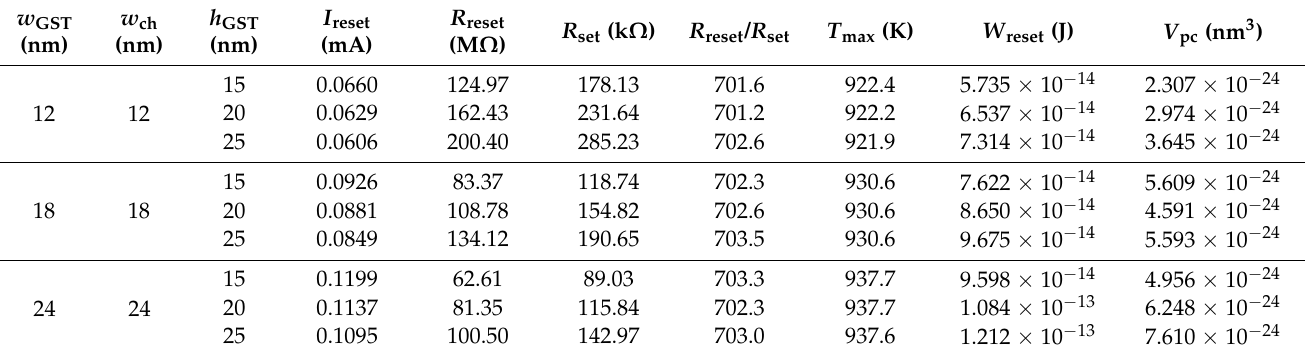
Table 2. Simulated results of the PCM cells with different w GST and h GST